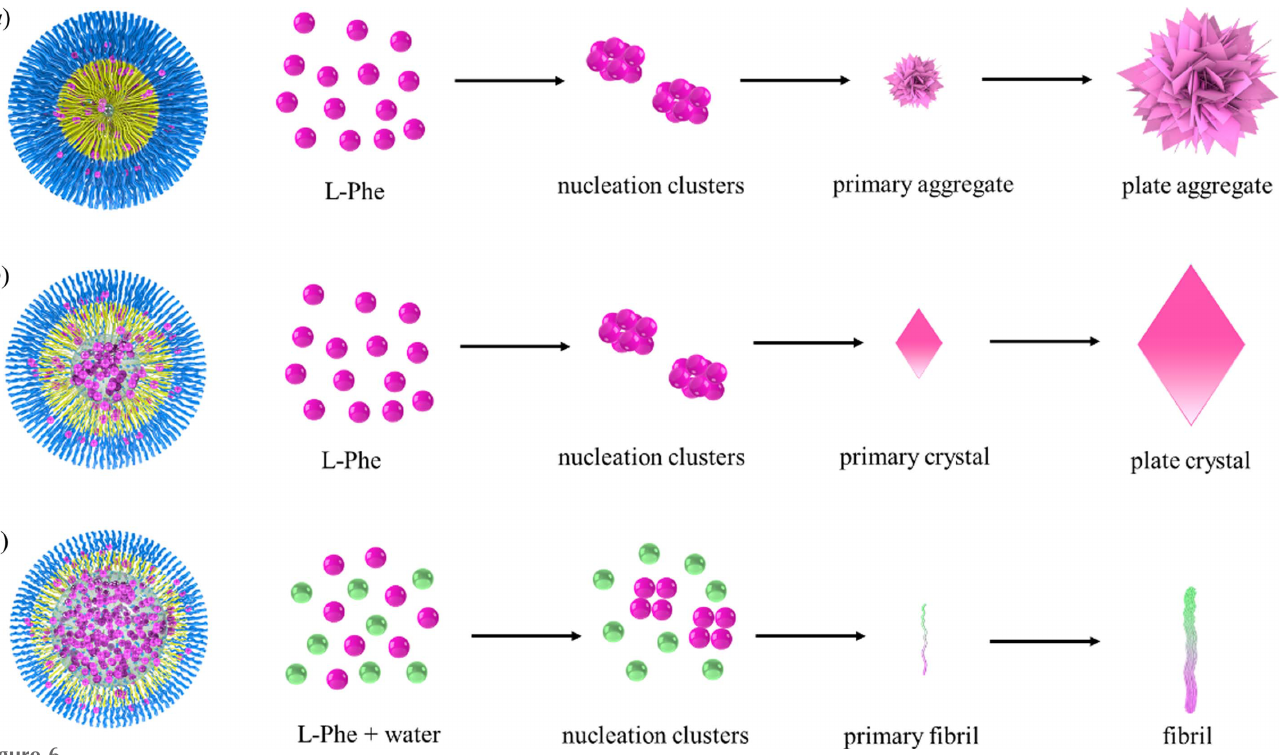
Figure 6 Dynamic evolution process of l -Phe self-assembly in the ME of ( a ) aggregates, ( b ) plate-like crystals and ( c ) fibrils with increasing water content (or w o ).